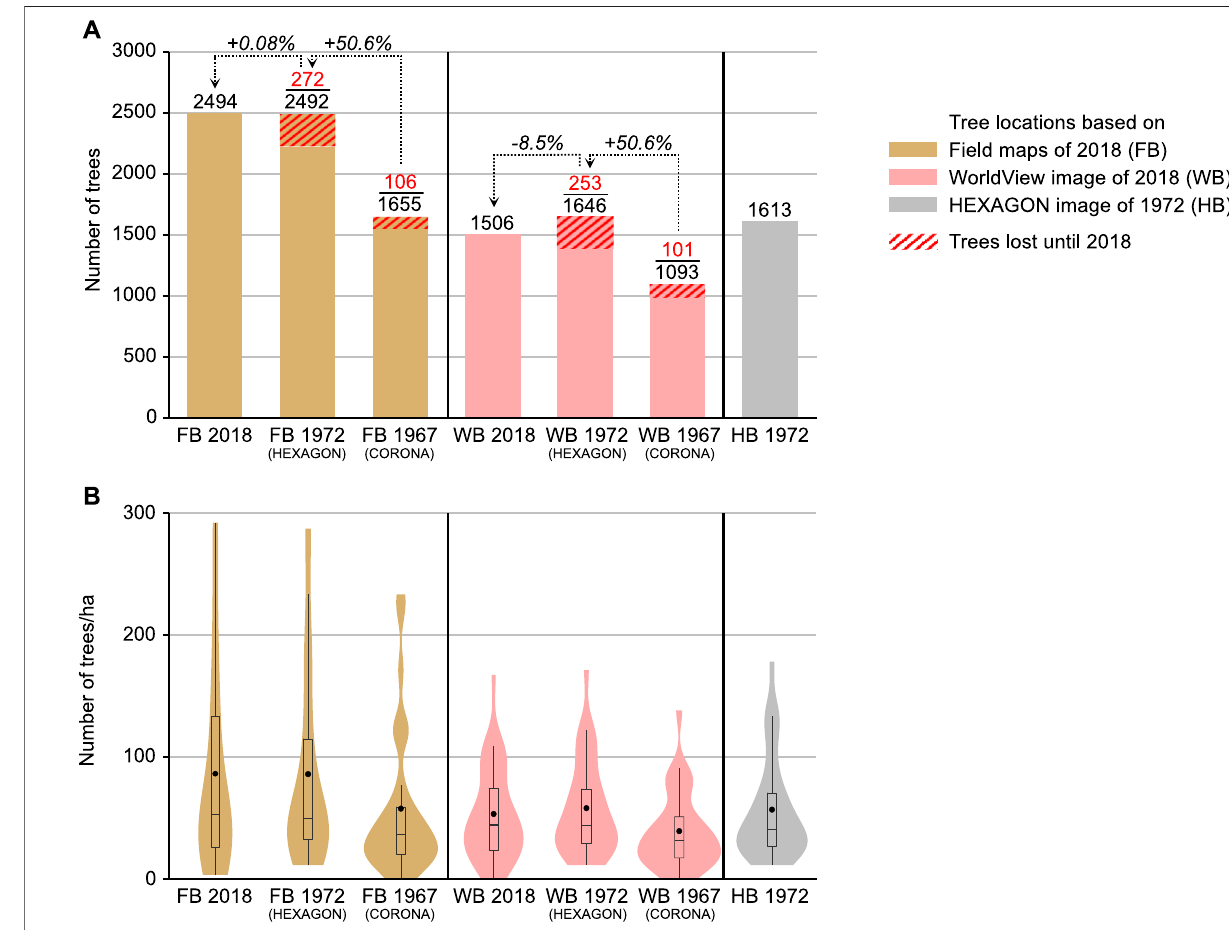
FIGURE6| Results ofargan-tree mappingon the30test sitesin2018, 1972and 1967according tothe fi eld-based (FB), WorldView-based (WB) andHEXAGON- based (HB) datasets. (A) Total numbers and net changes between dates; (B) Distribution of tree densities over the 30 test sites shown as violin plots (boxplot shows median and upper/lower quartiles; black dot shows mean). Note the difference in the shape of the violin plots between FB and WB and the similarity between WB 1972 and HB 1972.